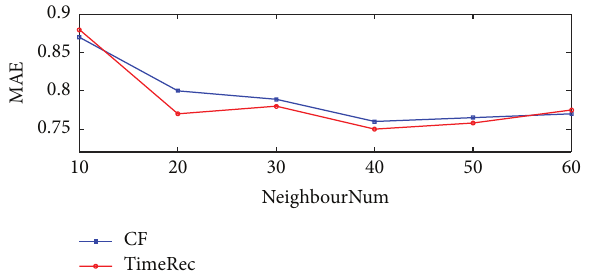
Figure 5: Influences of time on recommendation